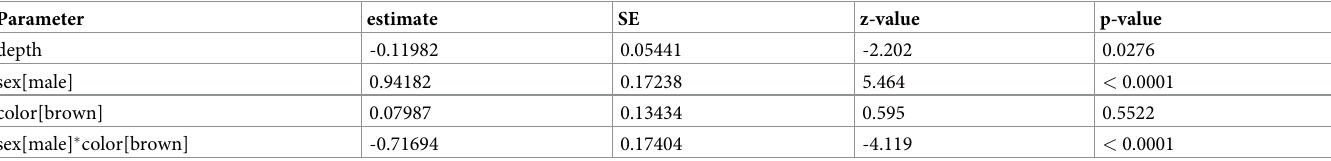
Table 1. Results of generalized linear mixed model for parasite burden across all parasite